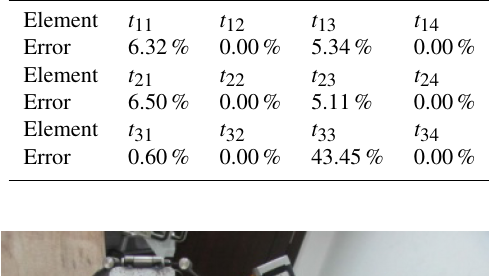
Table 1. Errors of the inverse kinematic solutions.